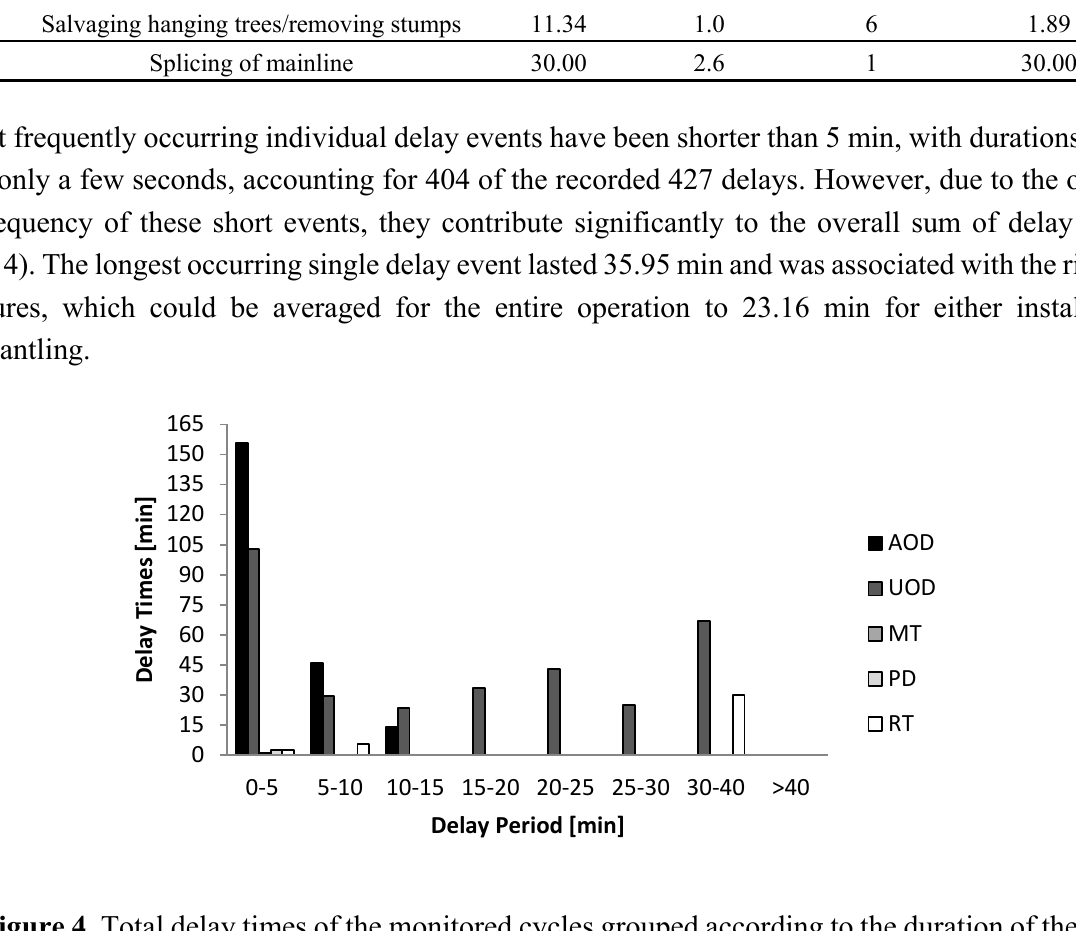
Figure 4. Total delay times of the monitored cycles grouped according to the duration of the single delay event